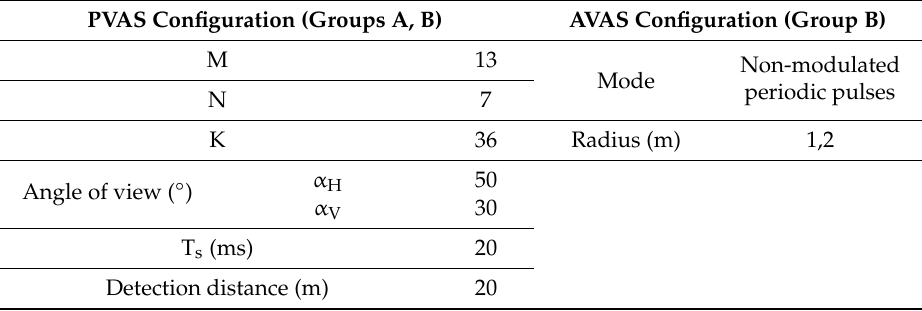
Table 1. Geometric-based virtual acoustic space (GbVAS) configuration for groups A and B. PVAS’ matrix of stereopixels ( MxN ), randomizer (K), angle of view, spawning period (T S ) and detection distance. AVAS’ mode of operation and detection range (radius).